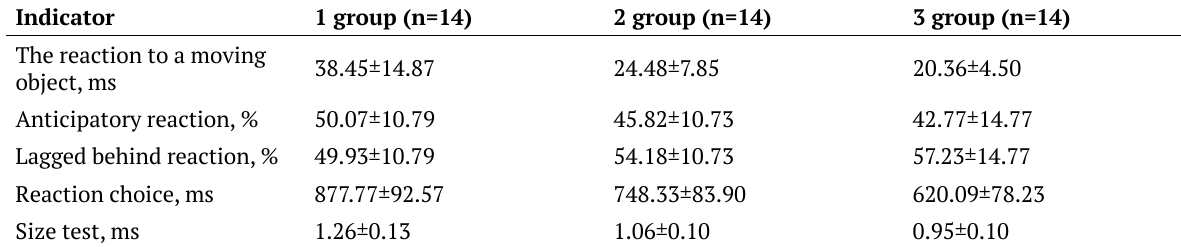
Table 1. Results of psychophysiological tests of taekwondo athletes of different age groups (X±SD) Indicator 1 group (n=14) 2 group (n=14) 3 group